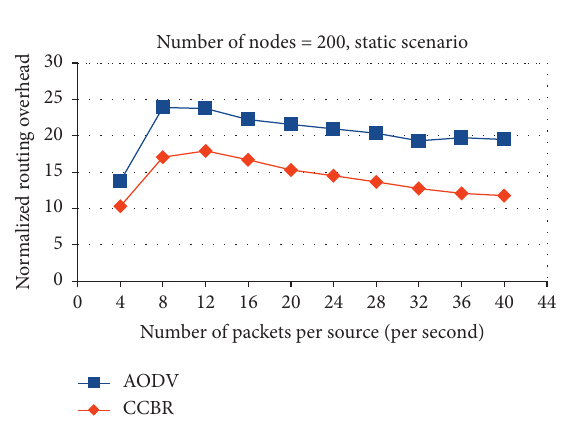
Figure 9: Normalized routing overhead.